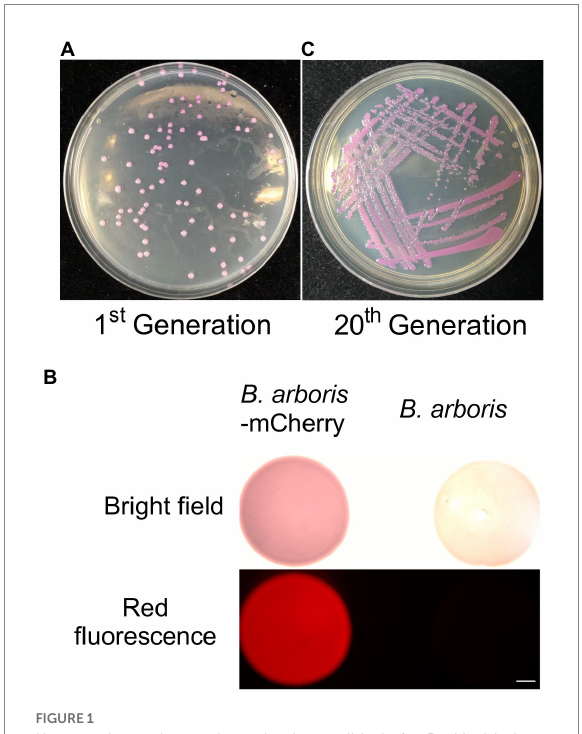
FIGURE 1 Kanamycin can be used as selection antibiotic for Burkholderia arboris . (A) Generation of B. arboris- mCherry using kanamycin resistance. Plasmids containing mCherry and kanamycin resistance genes were transferred to B. arboris , and positive clones were selected on the NA agar plate (90 mm) with 500 μ g/ml of kanamycin 48 h after cultivation at 28 ° C. (B) B. arboris- mCherry colonies under fluorescent microscopy. Bars, 1,000 mm. (C) The morphology of B. arboris -mCherry colonies after 20 generations